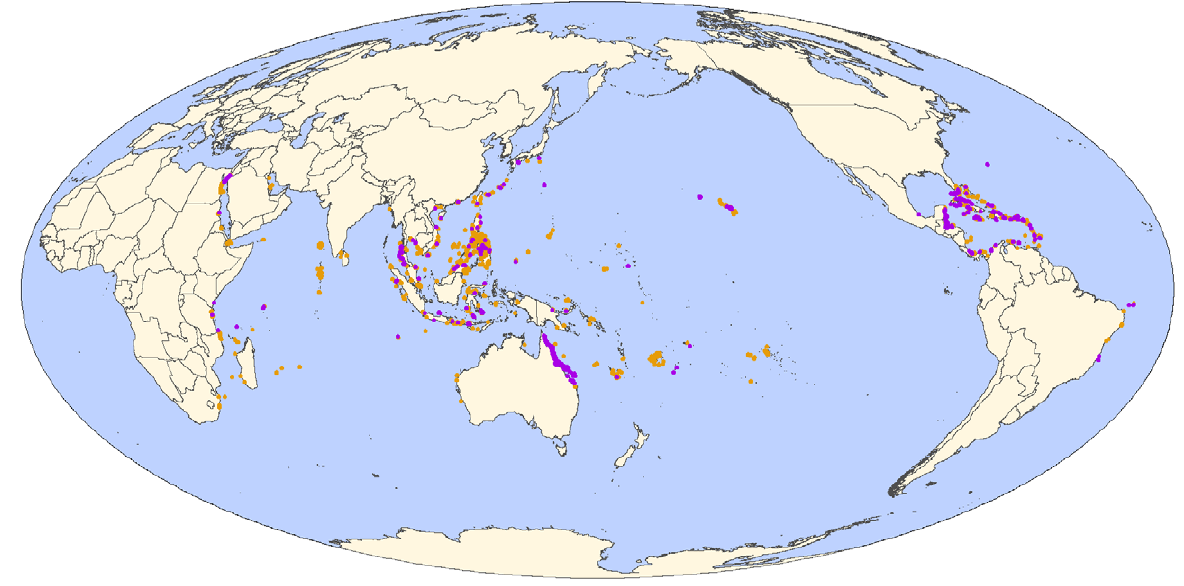
Figure 1. Location of unprotected (orange) and protected (purple) reef coral cover survey sites.